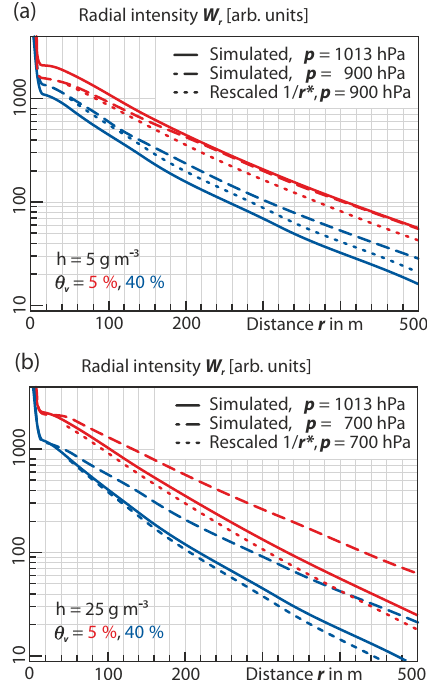
Figure A1. Pressure dependence of the weighting function W r demonstrated for two cases of air pressure and humidity. The rescaled p -adapted curves (dots, Eq. A1) are almost parallel to the non-adapted curves (solid), indicating that the normlized weight leads to the same results. (a) Dry midlands; (b) humid